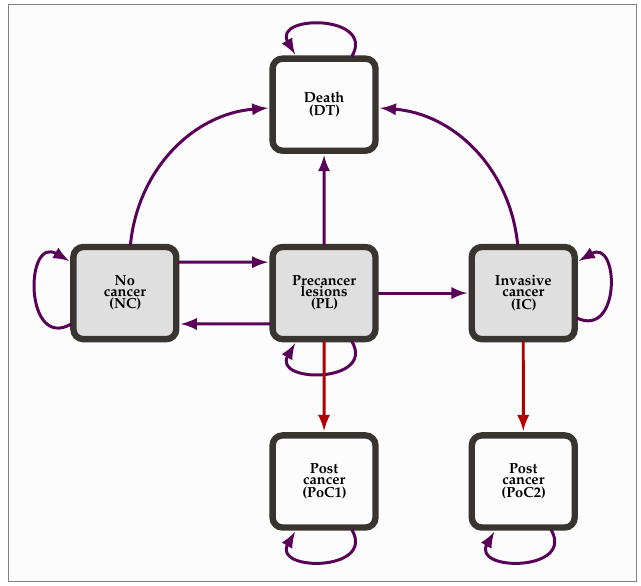
Figure 1. State transition